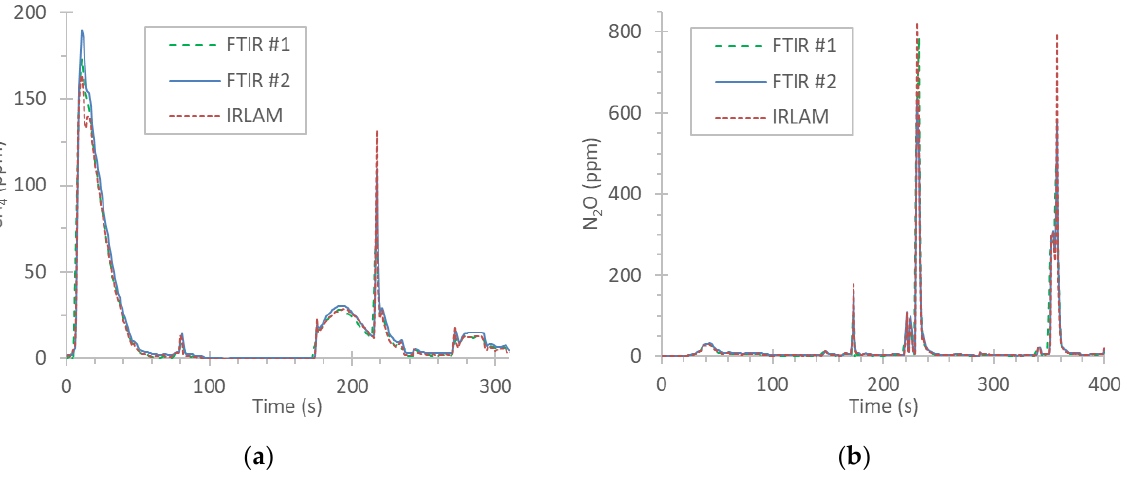
Figure 6. Real time tailpipe concentrations ( a ) CH 4 over a cold start WLTC of the gasoline Euro 6 (G6) vehicle; ( b ) N 2 O over a cold start WLTC at − 7 °C of the Diesel Euro 6 (D6) vehicle.